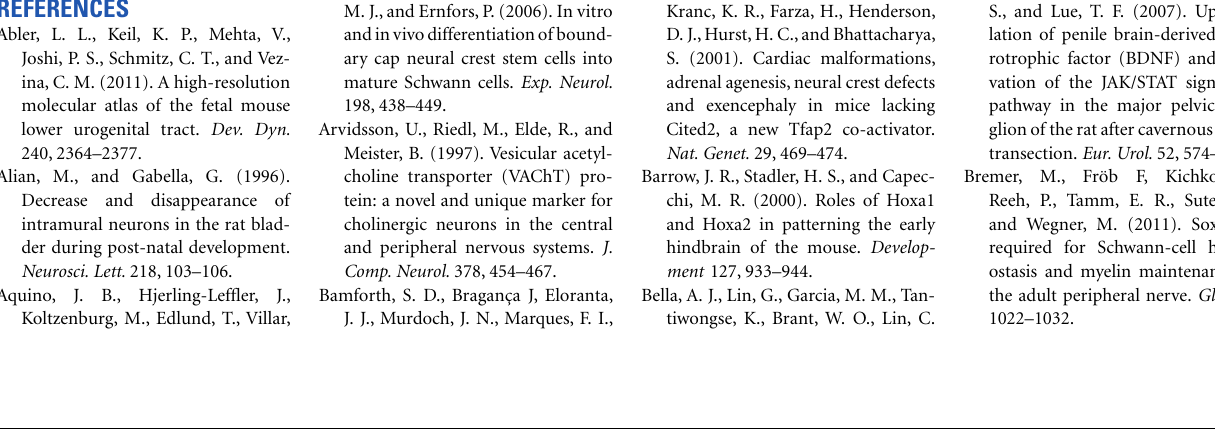
Table S 2 | RT-PCR primers utilized for each gene in the RT-PCR